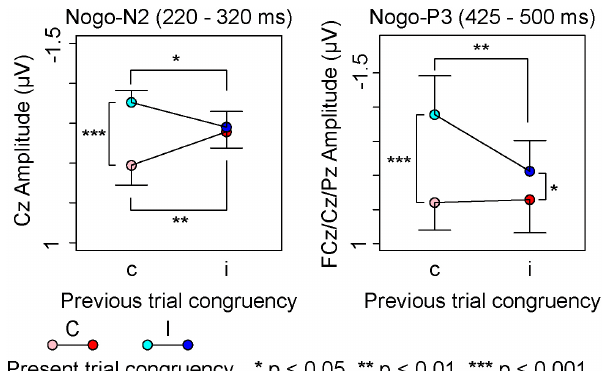
FIGURE 6 | Main results of event-related potential components for Nogo-stimuli; “c” and “C” represents congruent stimuli on previous and present trials, respectively. “i” and “I” represents incongruent stimuli on previous and present trials, respectively.